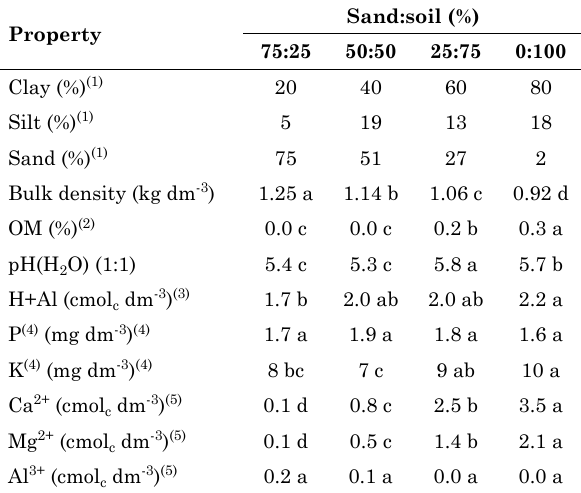
Table 1. Soil physicochemical properties